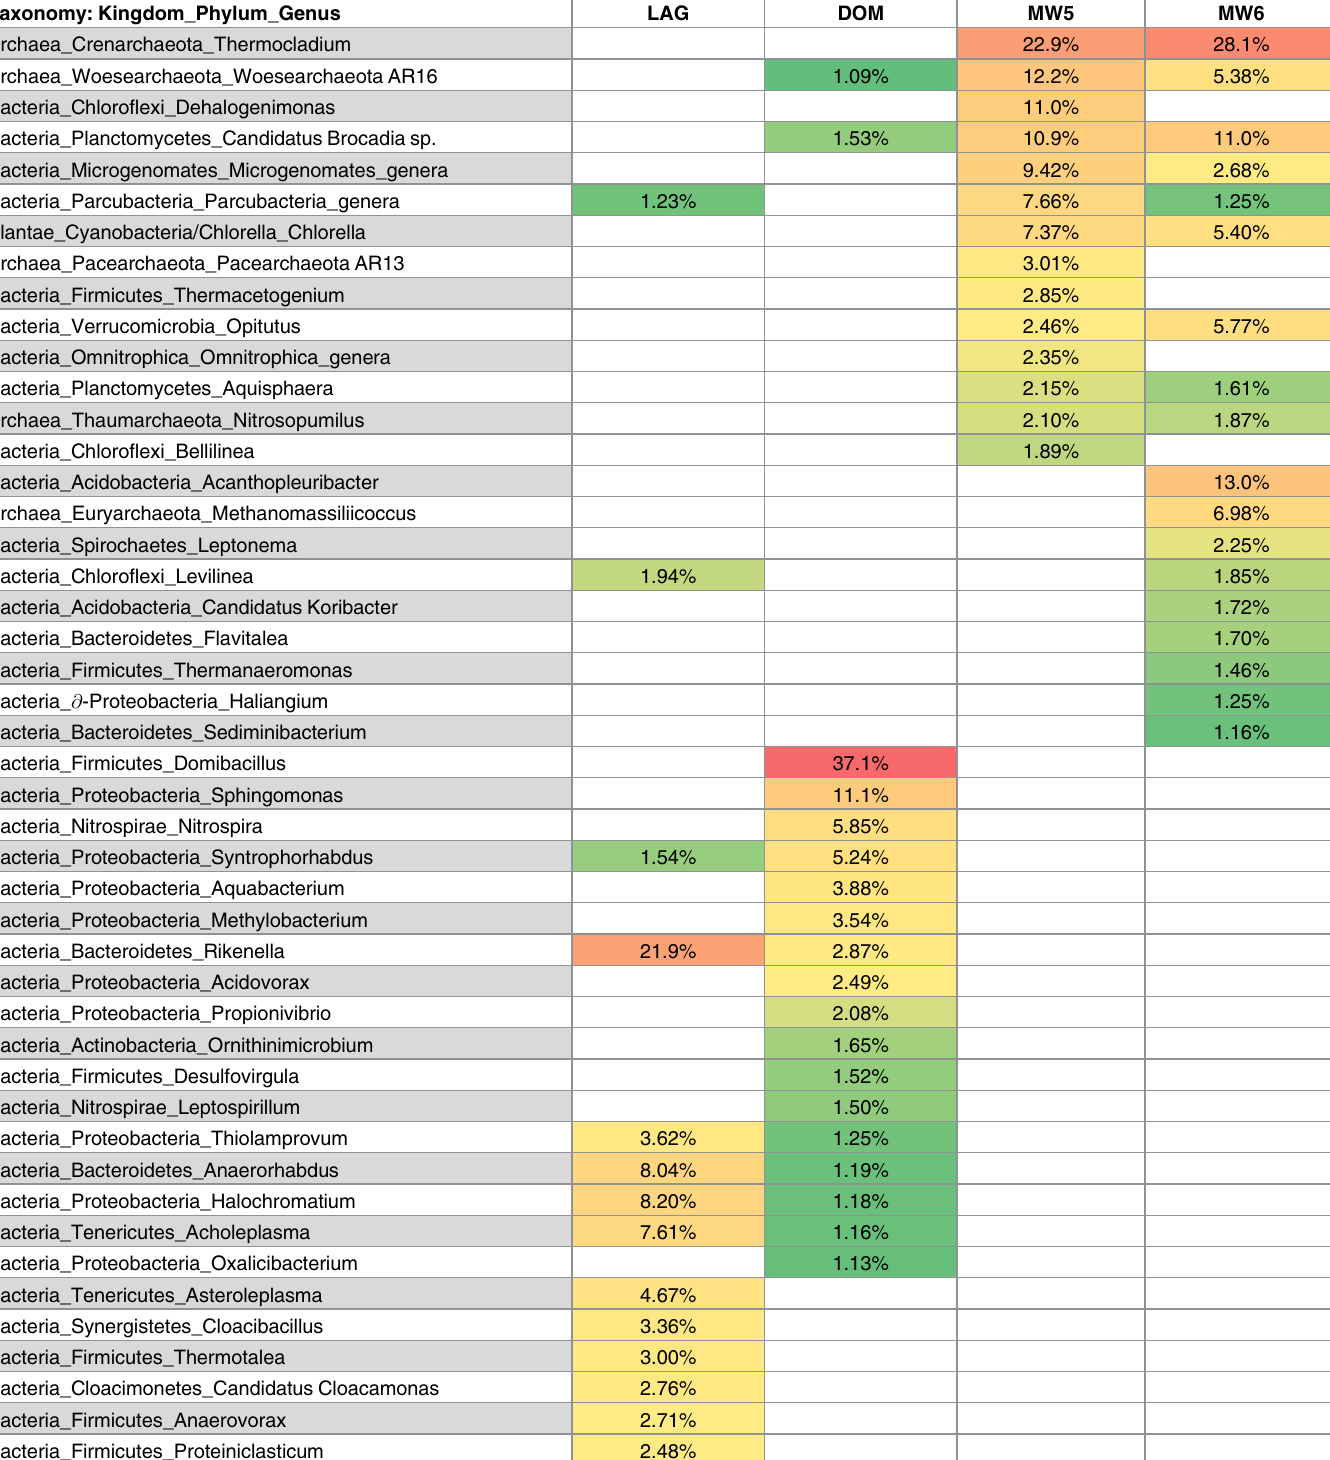
Table 3. Taxonomic relative abundances for the four water samples based on 16S rRNA gene abundances. Frequenciesof taxa present at > 1.1% rel- ative abundance are displayed. Standarderror of the proportionis less than 0.4% for all observations. Color scalingrelative abundances: red = high; yellow = moderate; green =